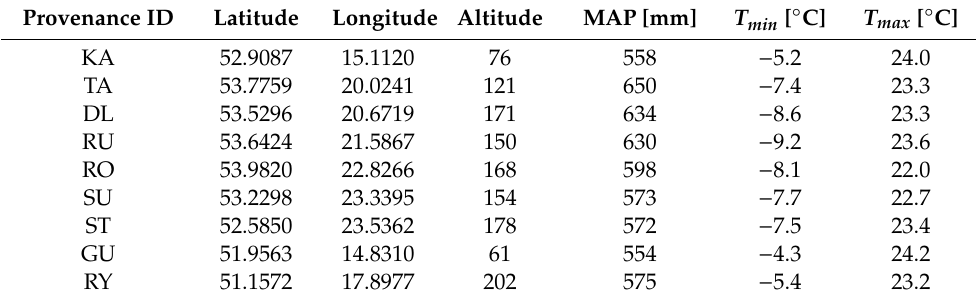
Scots pine provenances included in the study. MAP—mean annual